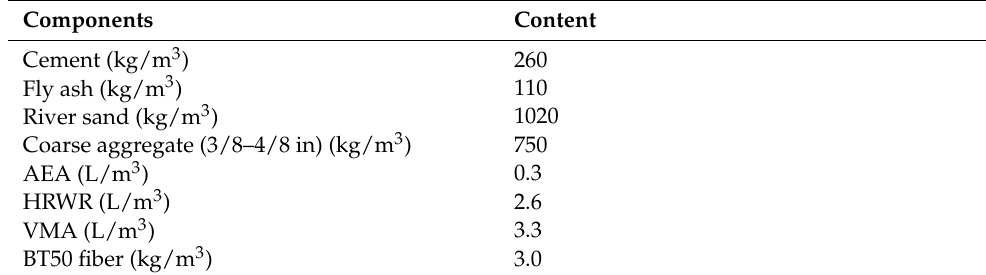
Table 1. Mix proportions of